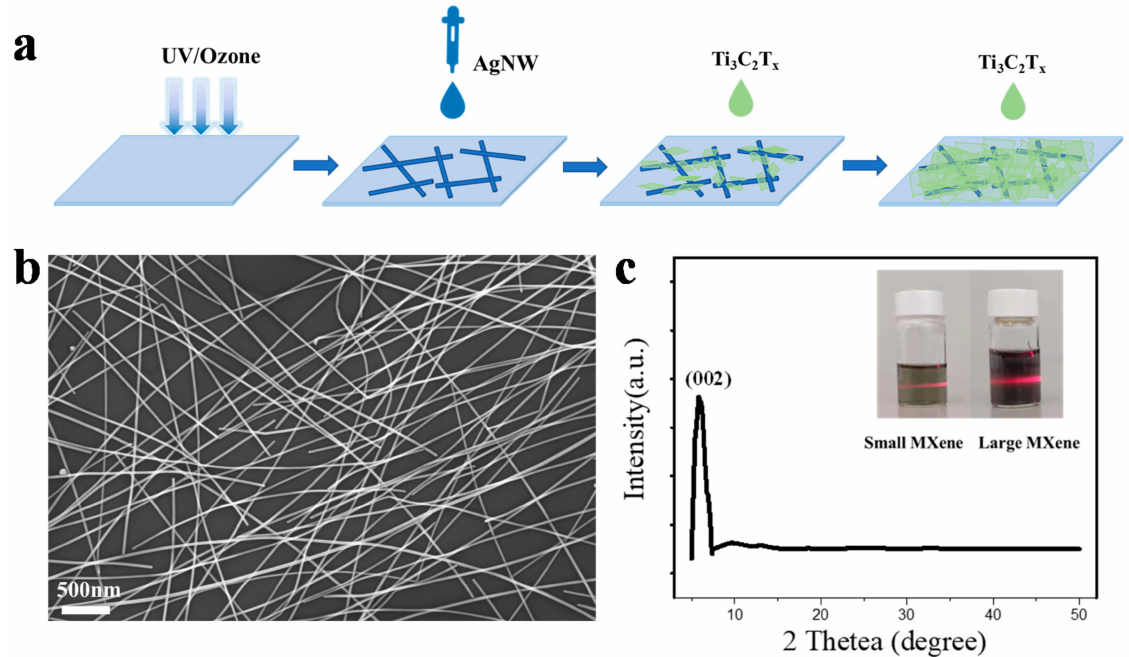
Figure 1. ( a ) Schematic illustration of the AgNW/MXene hybrid transparent conductive films. ( b ) SEM image of AgNWs network. ( c ) XRD patterns for MXene and the graph of Tyndall scattering phenomenon for MXene dispersion